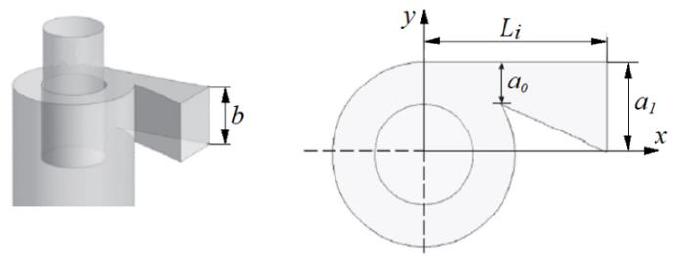
Figure 11. Geometry of the inlet channel of the return cyclone. Figure made by the author based on data from work [78].